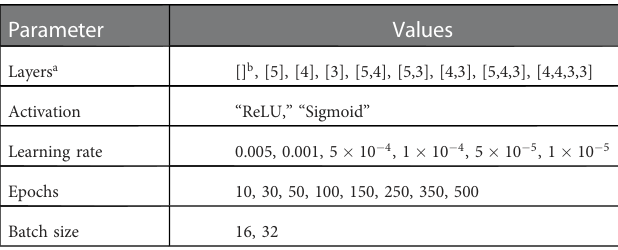
TABLE 5 Grid search